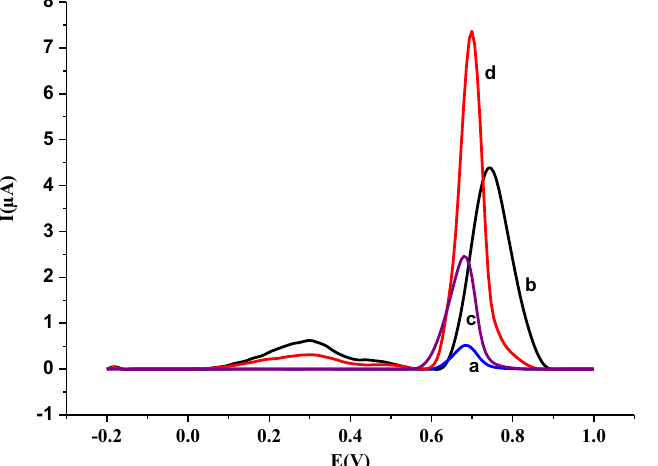
Figure 8. ( a ) Voltammogram of 5 × 10 –6 M IDA in pH 1.5 phosphate buffer using a) bare GCE by DPV method ( b ) Ru@VC/GCE by DPV method ( c ) bare GCE by AdSDPV method with 0.0 mV accumulation potential, 30 s accumulation time ( d ) Ru@VC/GCE by AdSDPV method with 0.0 mV accumulation potential, 30 s accumulation